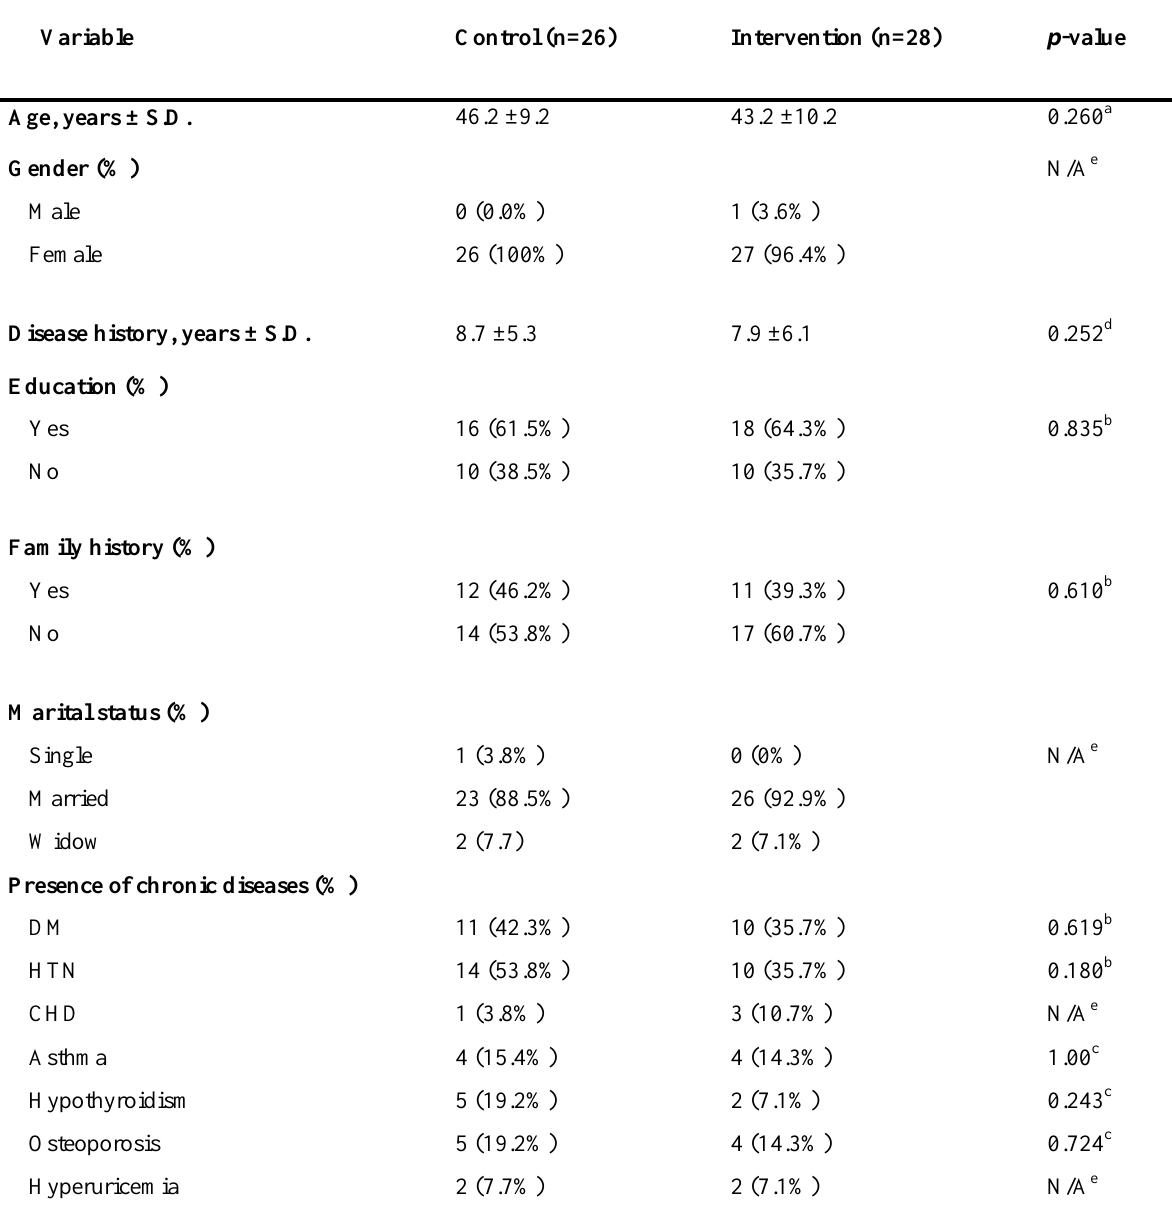
Table 1. Patients’ demographics for the study groups Variable Control (n=26) Intervention (n=28) p -value Age, years ± S.D. 46.2 ±9.2 43.2 ±10.2 0.260